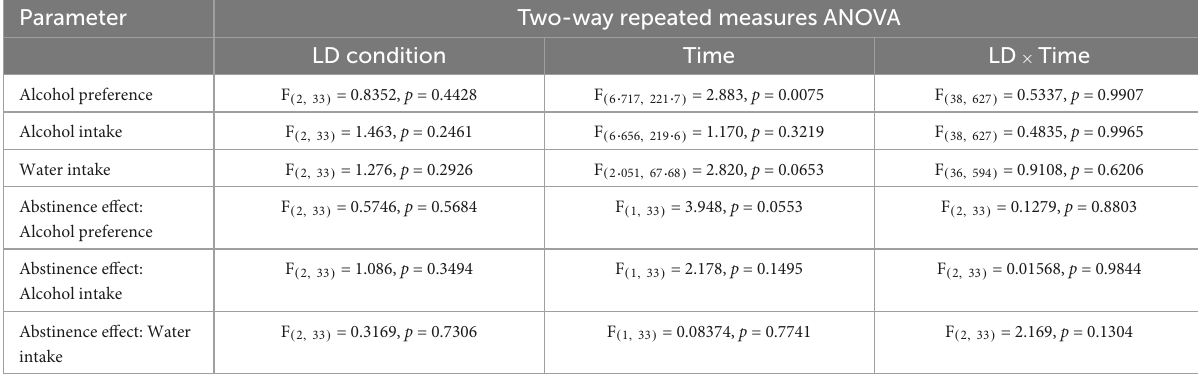
TABLE 2 Statistical results of fluid consumption and the abstinence effect on fluid consumption. Parameter Two-way repeated measures